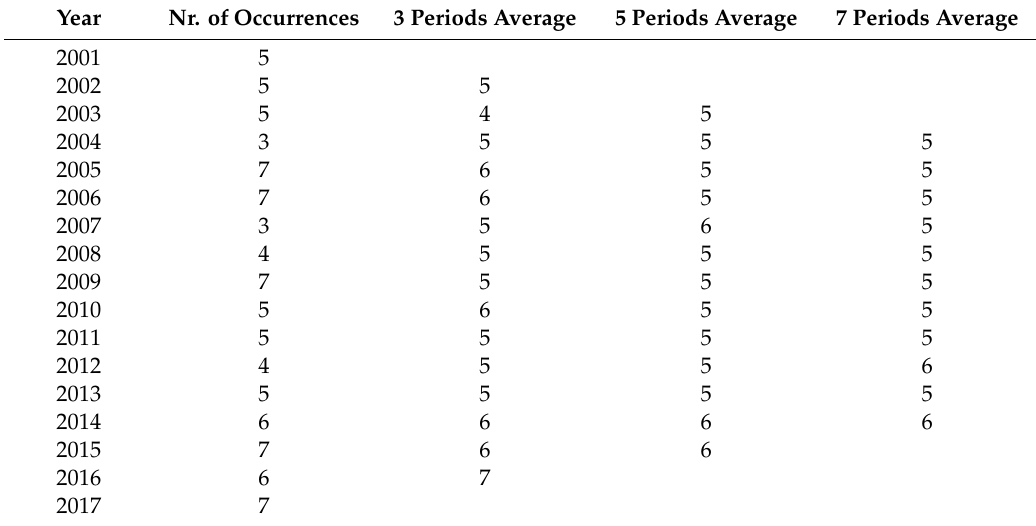
Table 4. Results obtained from the application of the simple moving average method.